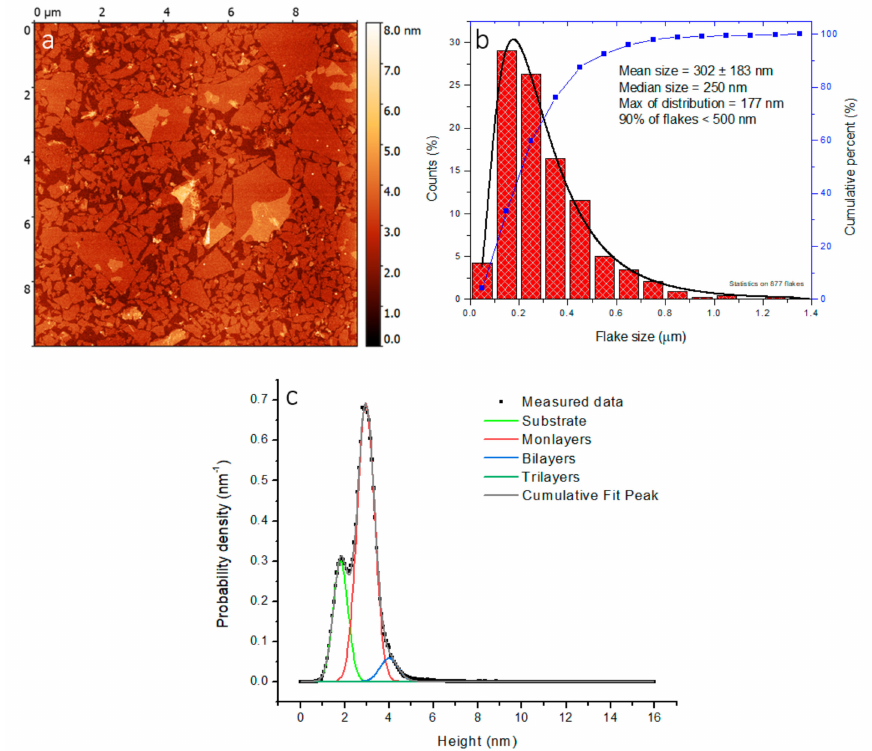
Figure 4. Purified graphene oxide: ( a ) atomic force microscopy (AFM) image, ( b ) size distribution of the graphene oxide platforms and ( c ) height analysis of AFM scan. The analysis of AFM scans was done by program Gwyddion [52] The size distribution was obtained manually.